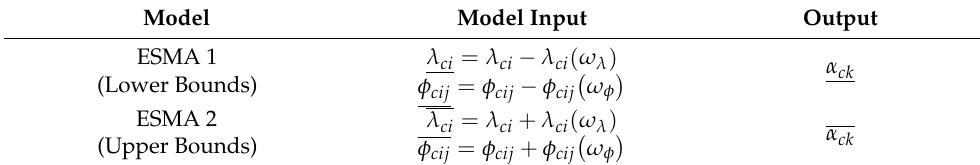
Table 1. Model input and output